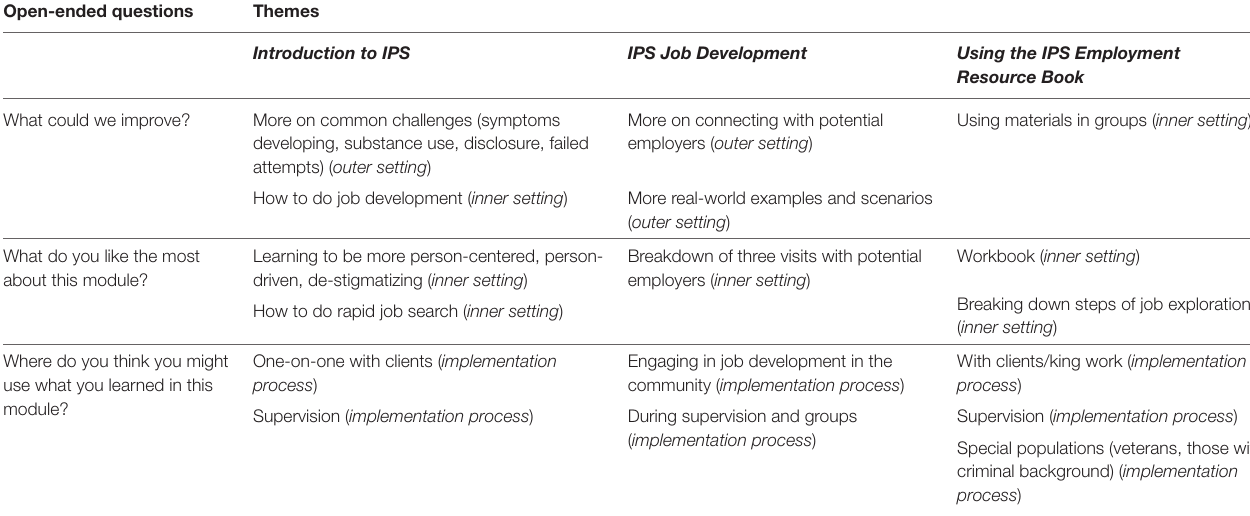
taBle 4 | Themes and CFIR domains from level 1 survey open-ended questions for individual placement and support (IPS)